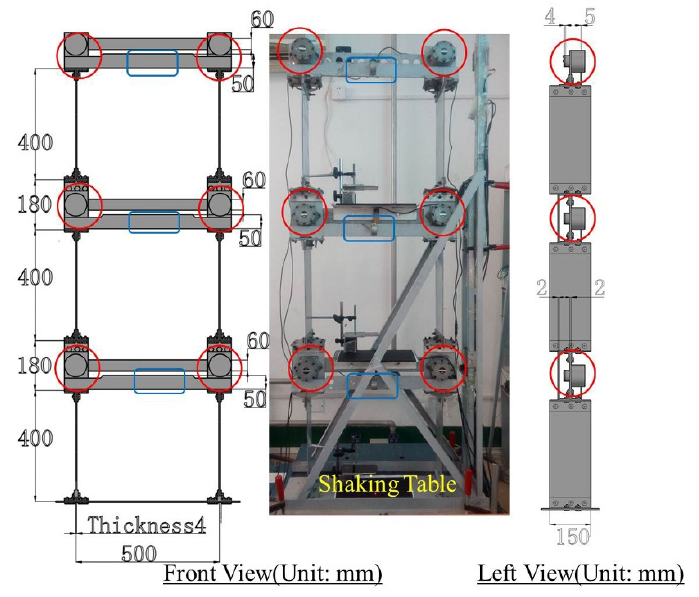
Figure 1. Illustrations and a picture of the three-story steel frame tested are shown. Viscous dampers are circled in red, and the removable rigid beams are boxed in blue.